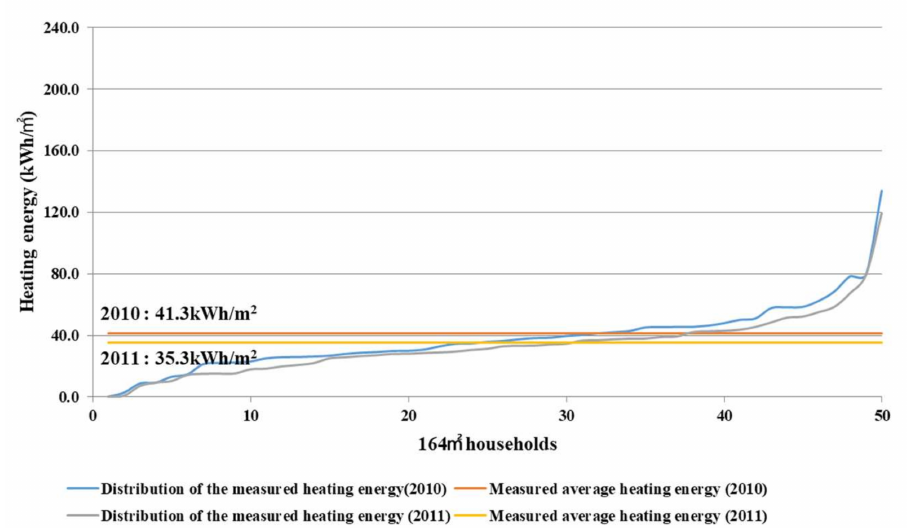
Figure 4. Analysis of the measured heating energy consumption of households sized 164 m 2 in 2010 and 2011.